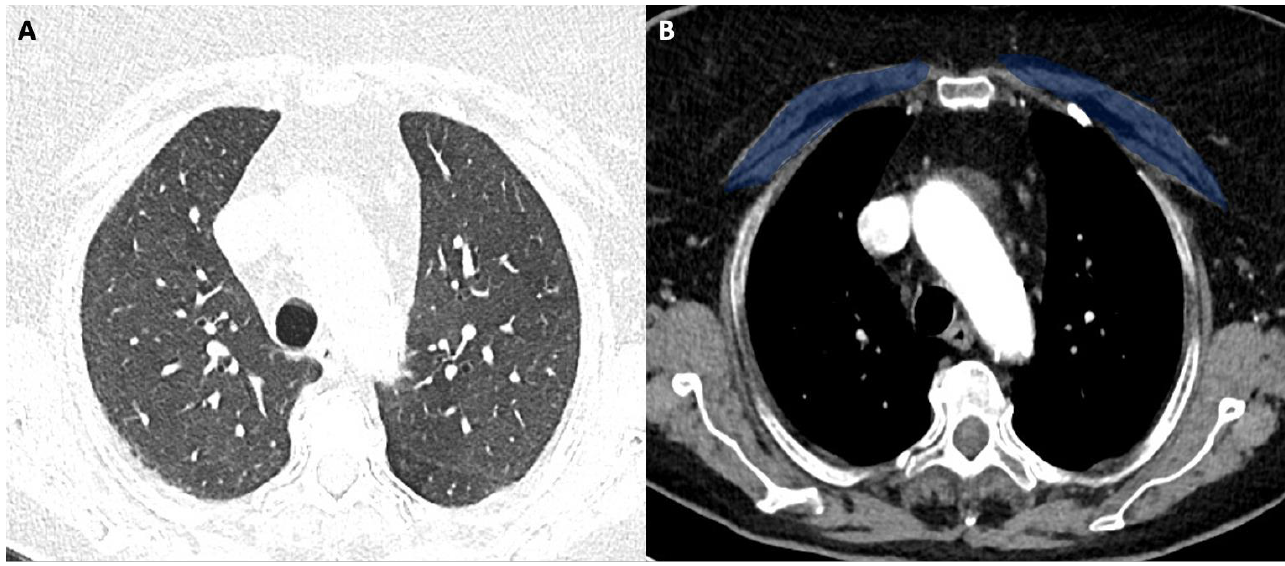
Figure 2 A-B 58-year-old female with COVID-19. Figure 2. ( A , B ) 58-year-old female with COVID-19.